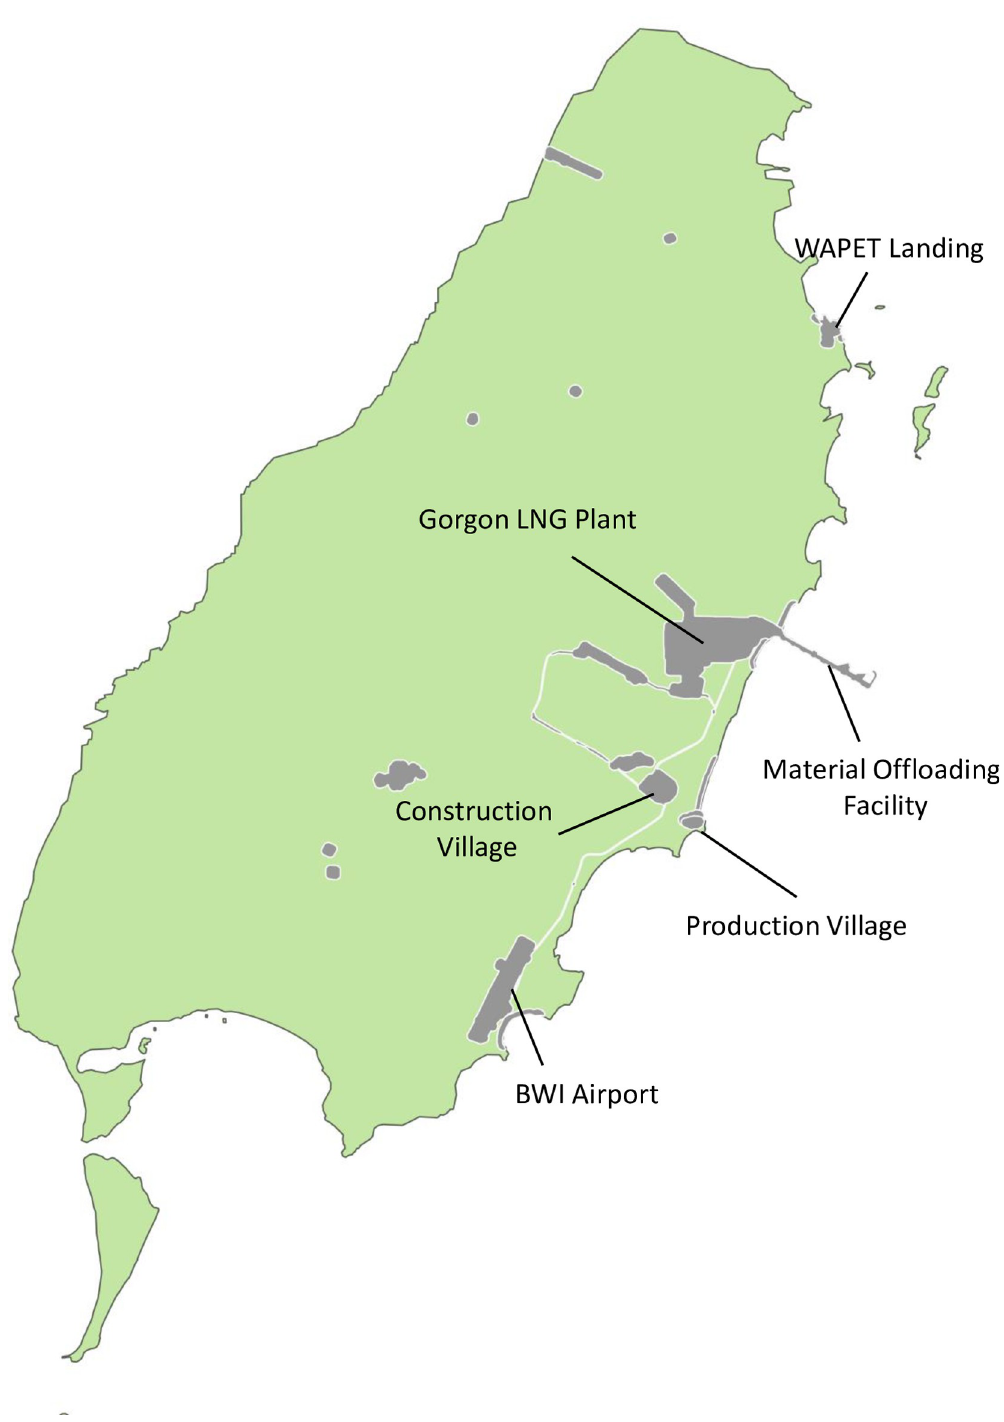
Fig 1. Physical definitions of biosecurity borders inspection points on Barrow Island, Australia. The map is an indicative representation of the biosecurity inspection sites between 2009 and 2015. Map created using the Free and Open Source QGIS. https://qgis.org/en/site/ [46]. The shapefiles were provided by Chevron Australia Pty Ltd. This work has been licensed under CC BY 4.0.